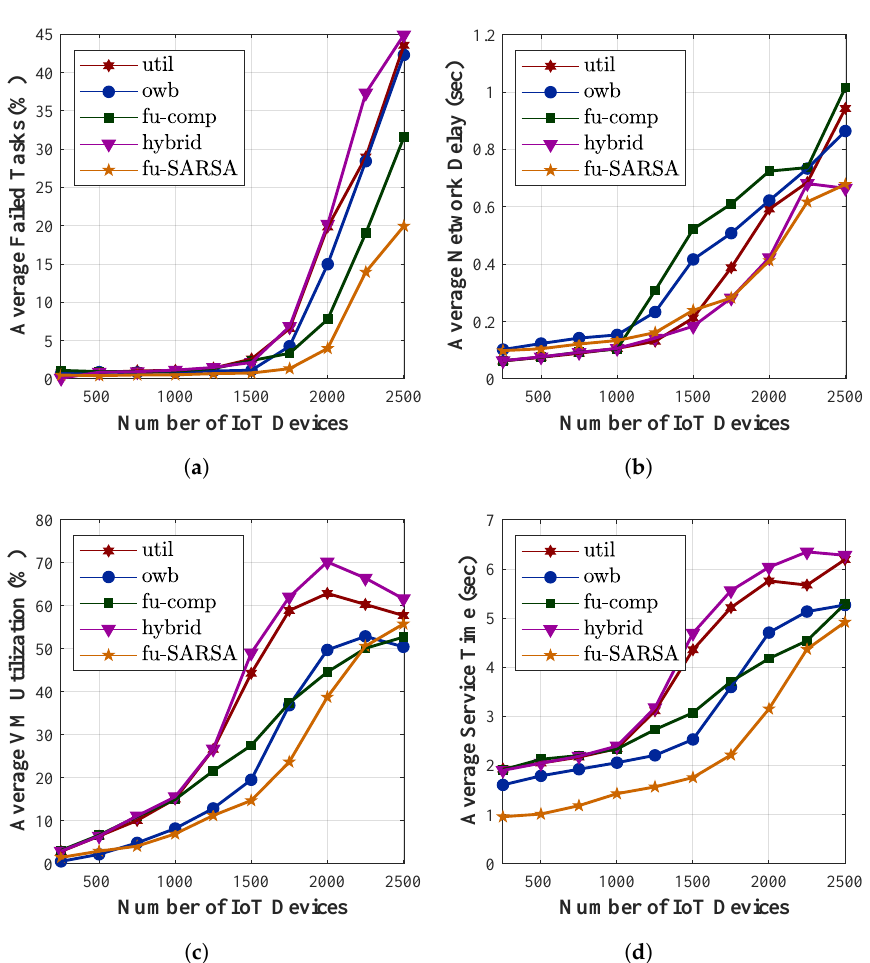
Figure 9. Comparative evaluations in terms of all application types: ( a ) Average task failure rate. ( b ) Average service time. ( c ) Average network delay. ( d ) Average VM